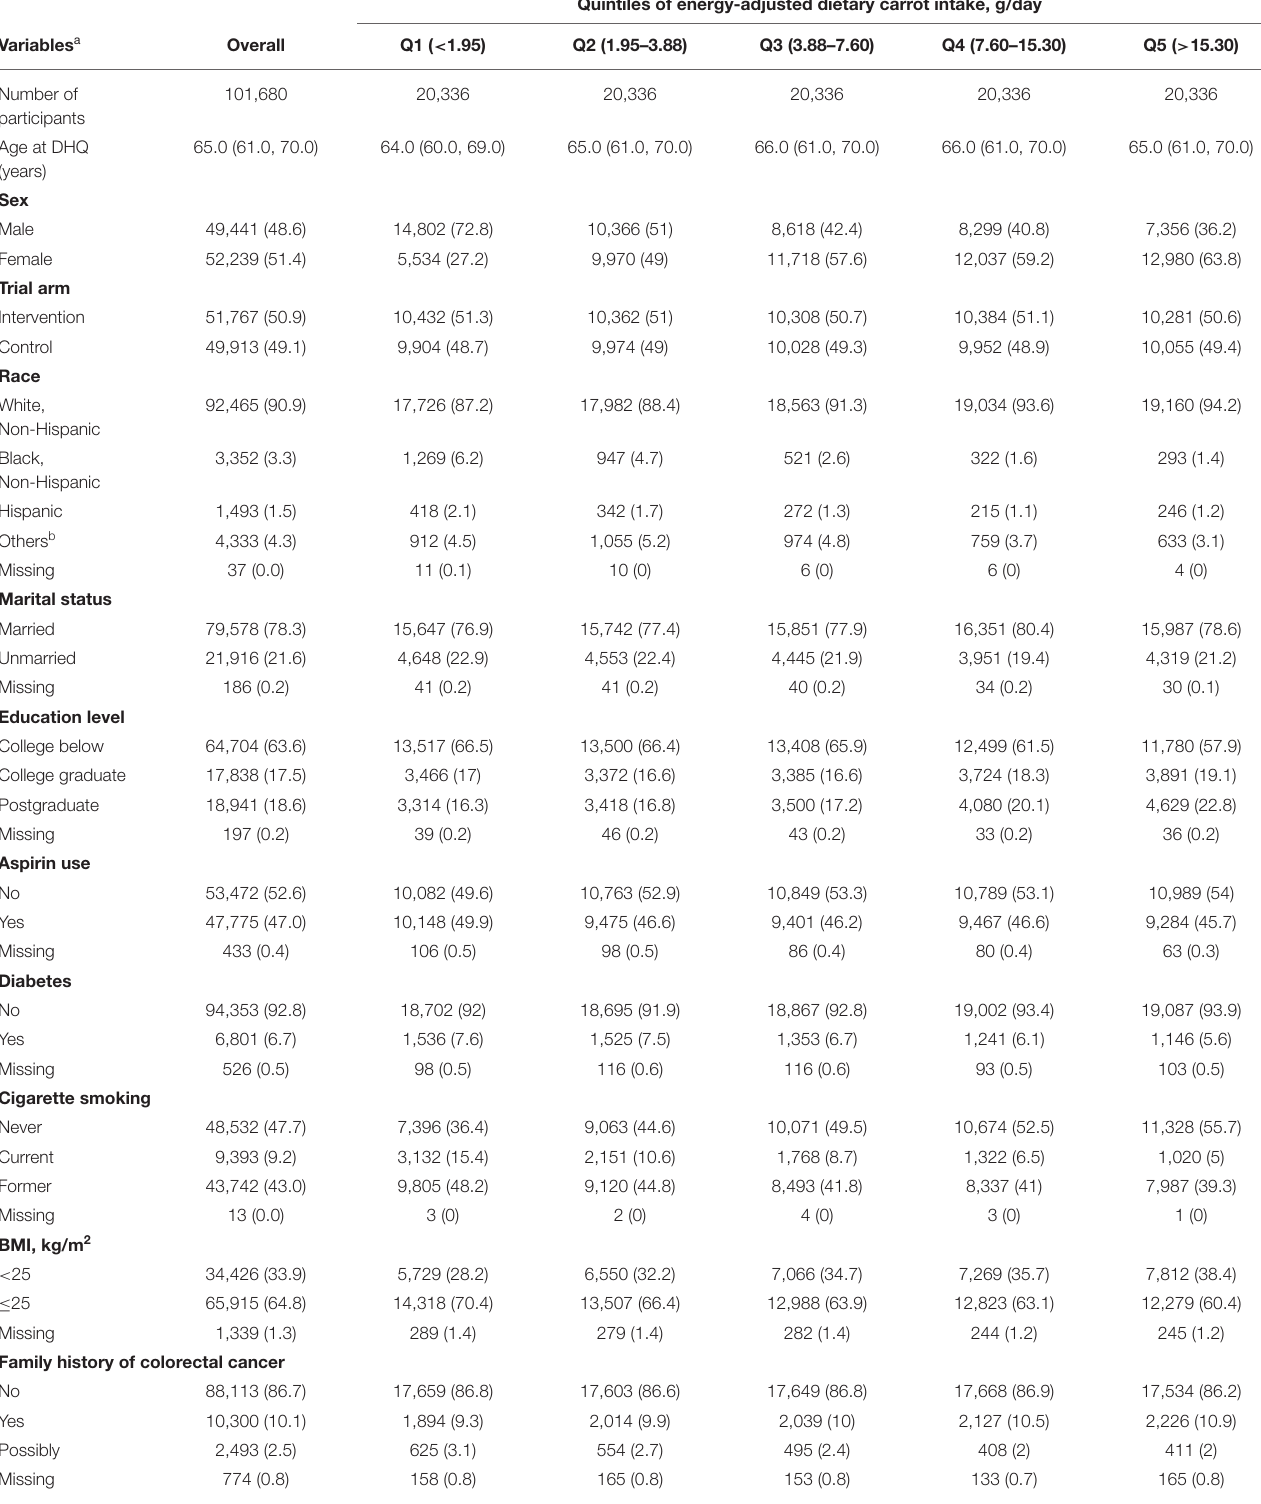
TABLE 1 | Baseline characteristics of study population according to quintiles of energy-adjusted dietary carrot intake in 101680 US participants. Quintiles of energy-adjusted dietary carrot intake,